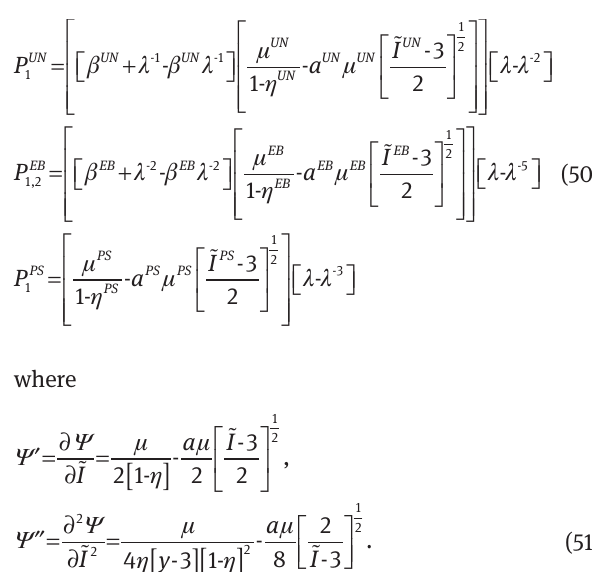
A current configuration setting for the above-mentioned stress tensor and tangent operator can be obtained from Kaliske and Rothert [12] . The optimal parameter sets after fitting each equation to the corresponding Treloar data are